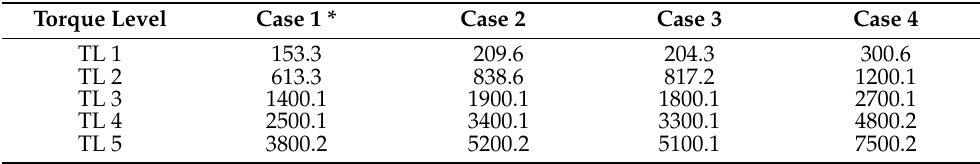
Table 8. The RMSE of walking ( × 10 − 6